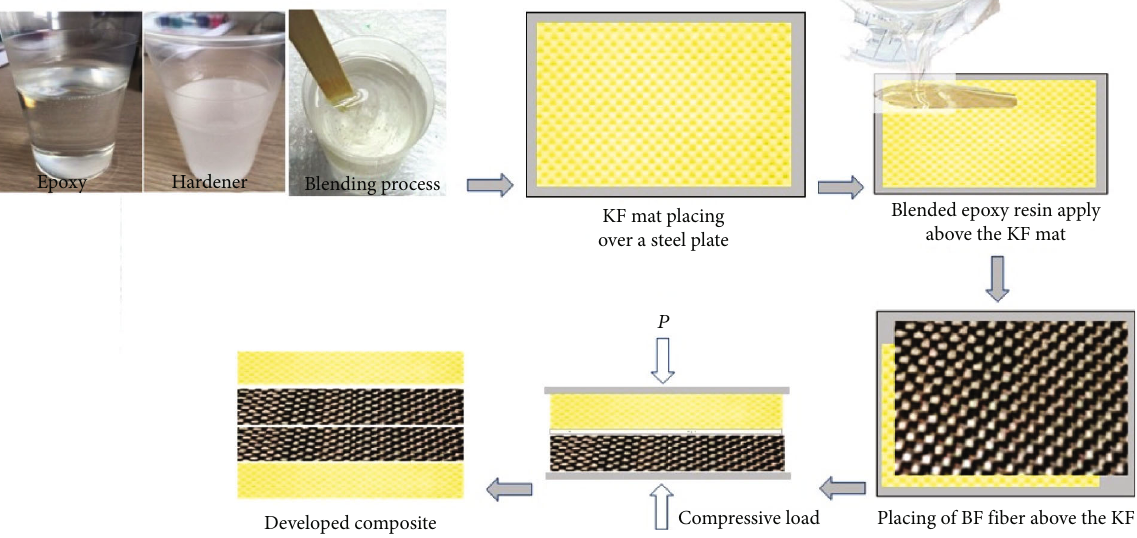
Figure 2: Flow process layout for epoxy hybrid composite fabrication.